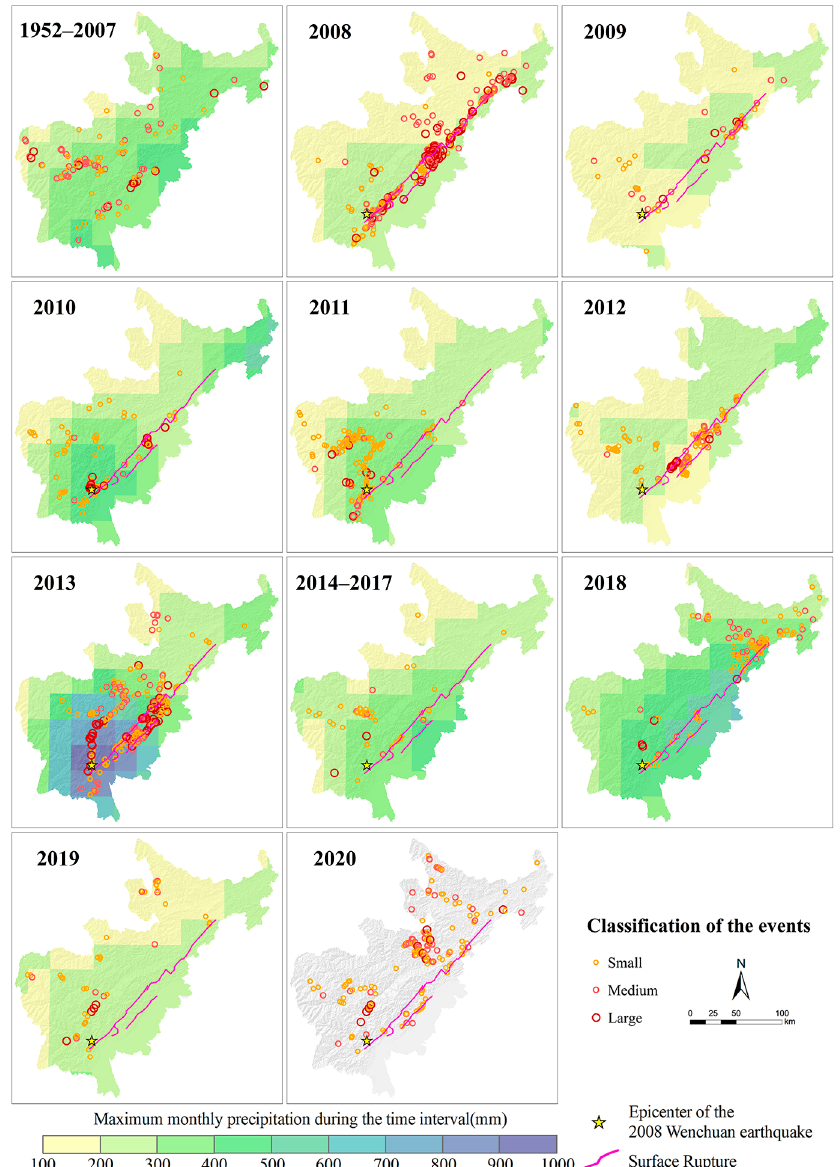
Figure 4. Distribution of debris flow events overlaid with the maximum monthly precipitation based on the GPCC data (25 × 25 km grid cells) with time. Events in 2000–2007 and 2014–2017 are shown as one time interval.